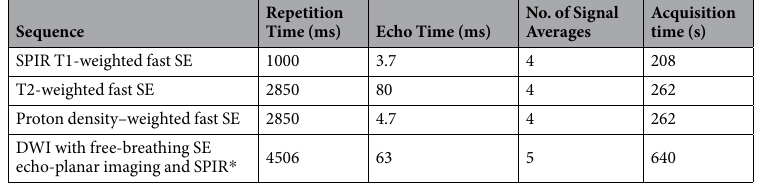
Table 6. Magnetic resonance imaging sequence parameters. SE = spin echo, SPIR = spectral presaturation with inversion recovery. All sequences were axial and two-dimensional (number of slices = 32, slice thickness =